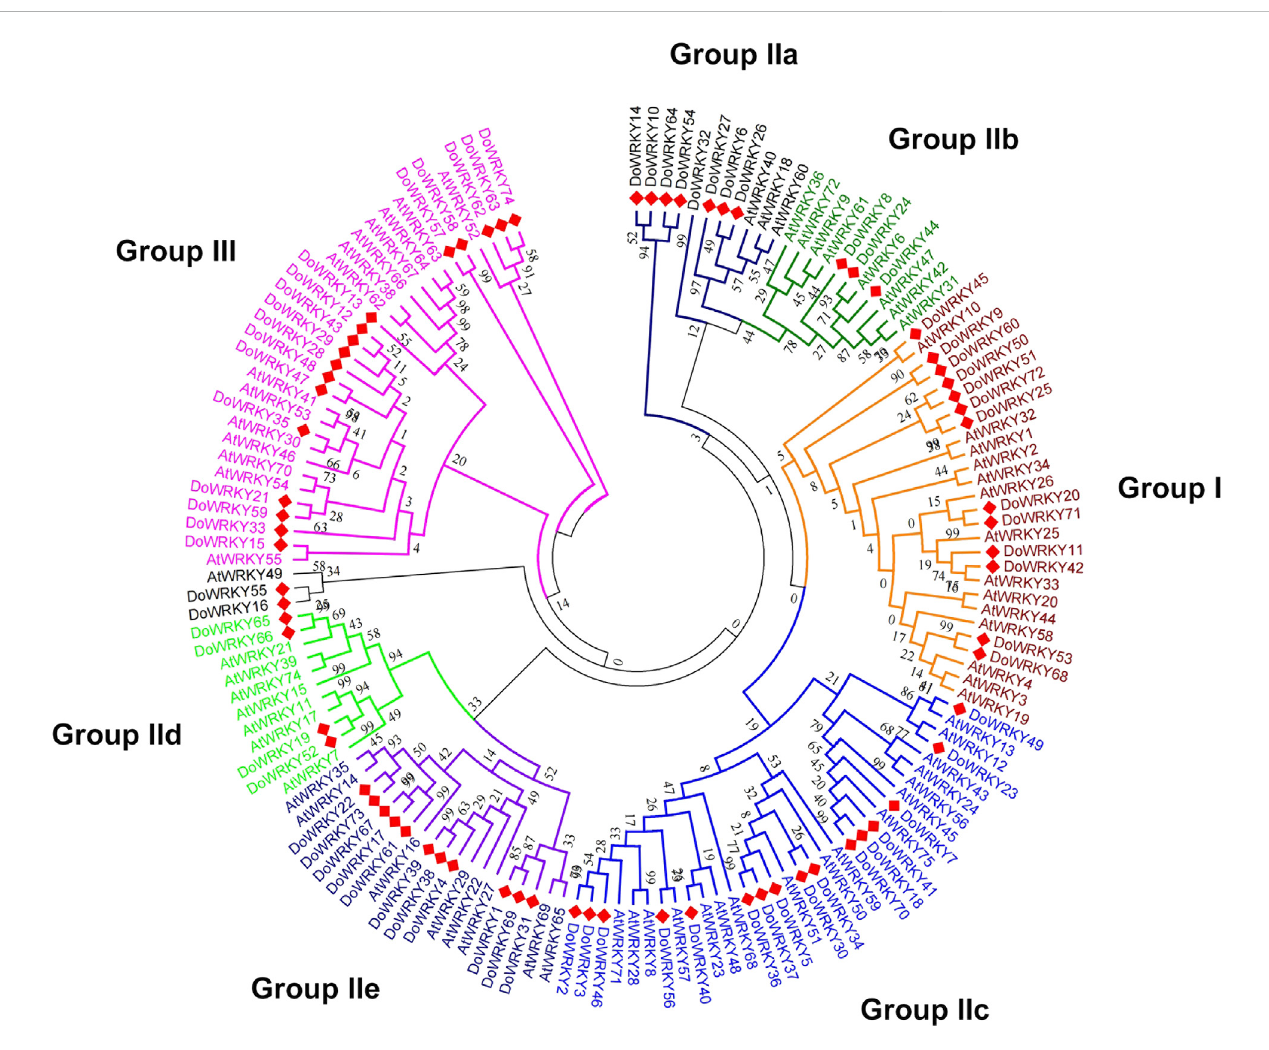
The phylogenetic tree of DoWRKYs and AtWRKYs by neighbor-joining